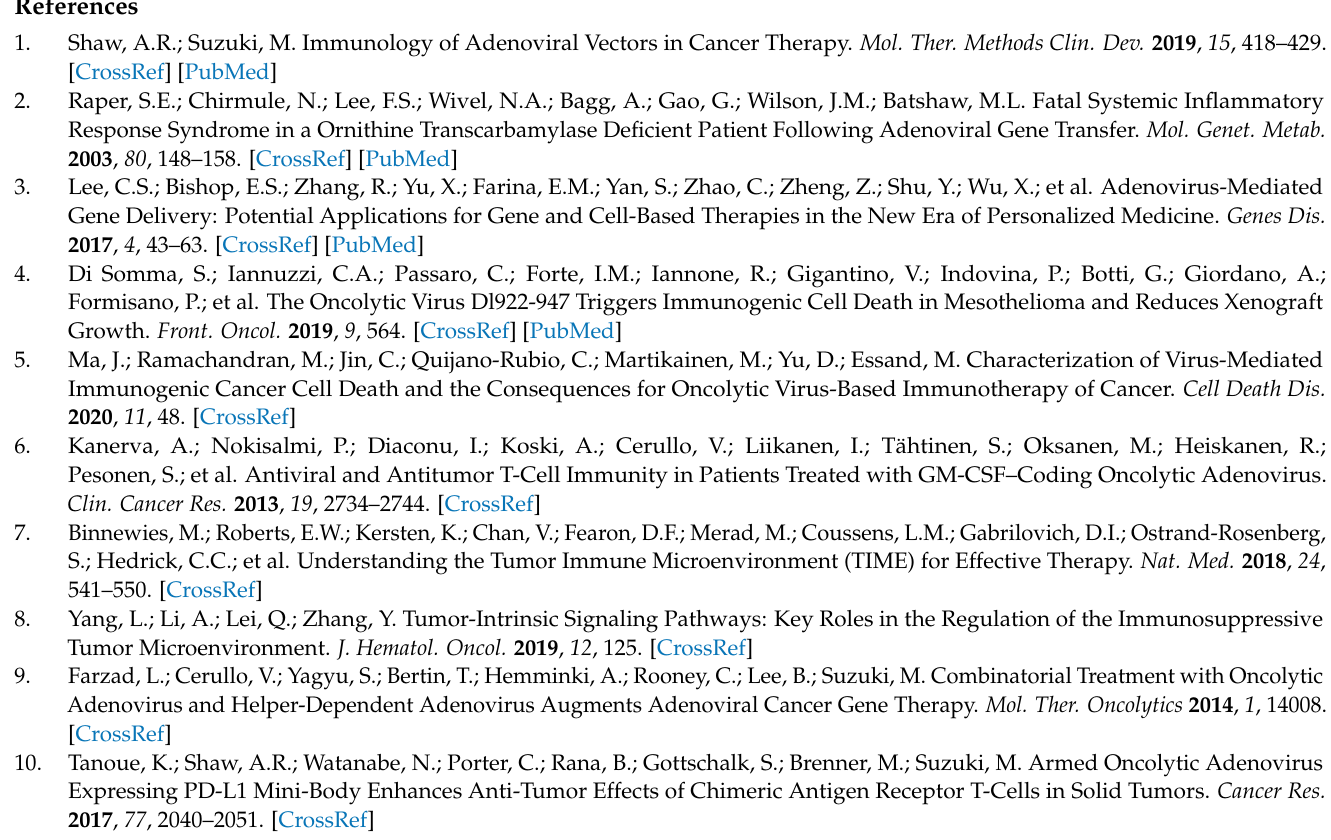
Figure S2: Complete, uncropped western blots for Figure 2; Figure S3: Minibody binding controls; Figure S4: Tumor target antigen expression; Figure S5: Complete, uncropped western blots for Figure 4; Figure S6: Complete, uncropped western blots for Figure